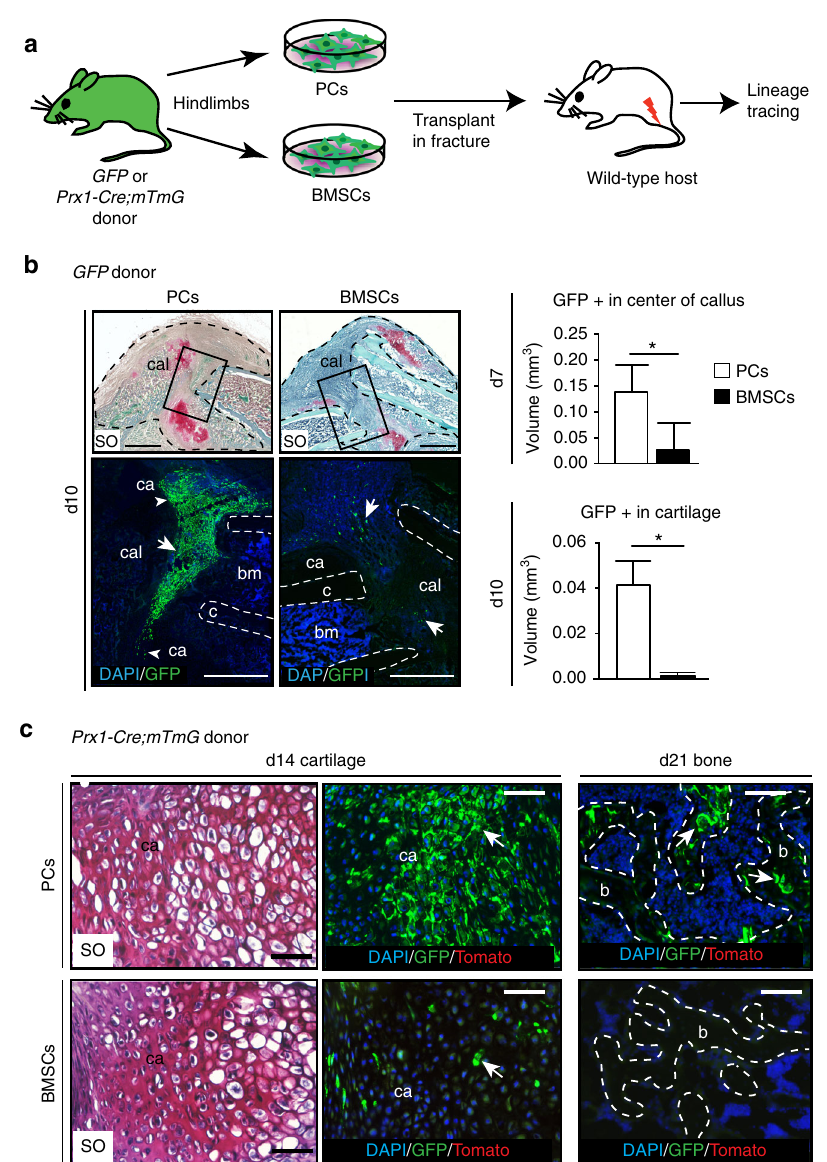
Fig. 3 PCs integrate ef fi ciently into the fracture callus. a Experimental design for the isolation of PCs and BMSCs from hindlimbs of GFP or Prx1-Cre ; mTmG donor mice and transplantation at the fracture site of wild-type hosts. b Lineage tracing of GFP + cells in the fracture callus. SO staining and DAPI/GFP immuno fl uorescence on longitudinal sections of mouse fractured tibias at day 10 post-transplantation shows PCs migrating very far in the callus (white arrow) and integrating in cartilage (white arrowhead). Histomorphometric analyses of the volume occupied by GFP + cells showing increased volume for PCs compared to BMSCs in the center of the callus at d7 ( n = 5 per group) and increased volume in cartilage by day 10 (d10) ( n = 4 per group). Black dashed line: callus, white dashed line: bone cortex, white arrows point to transplanted cells. Scale bar: 1 mm. c SO staining and DAPI/GFP/Tomato signals on longitudinal sections of wild-type mouse fractured tibias at days 14 (d14) and 21 (d21) post-transplantation of PCs (left column) or BMSCs (right column) isolated from Prx1-Cre;mTmG donors. High magni fi cation of SO staining showing hypertrophic cartilage in the center of the callus and DAPI/GFP/ Tomato signals on adjacent sections showing PCs and BMSCs Prx1-derived chondrocytes only marked by GFP (and Tomato-negative) at d14 (white arrows). By d21, PC Prx1-derived osteocytes marked by GFP (white arrows) were found in new bone (delimited by white dashed line), but no BMSC Prx1- derived osteocytes were detected. Scale bar: 125 μ m. SO: Safranin-O/Fast Green, cal: callus, c: cortex, ca: cartilage, b: bone. Statistical differences between the groups were determined using Mann – Whitney test (* p ≤ 0.05, ** p < 0.001). All data represent mean ±